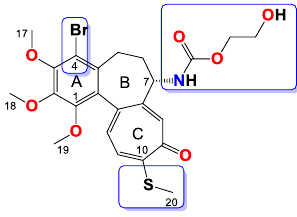
Figure 5. Structure of compound 5 .